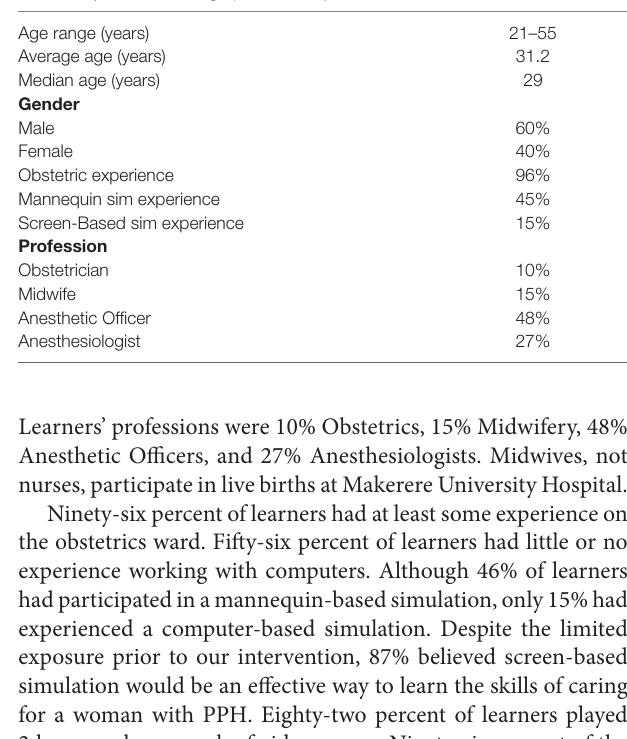
TaBle 1 | General demographics of